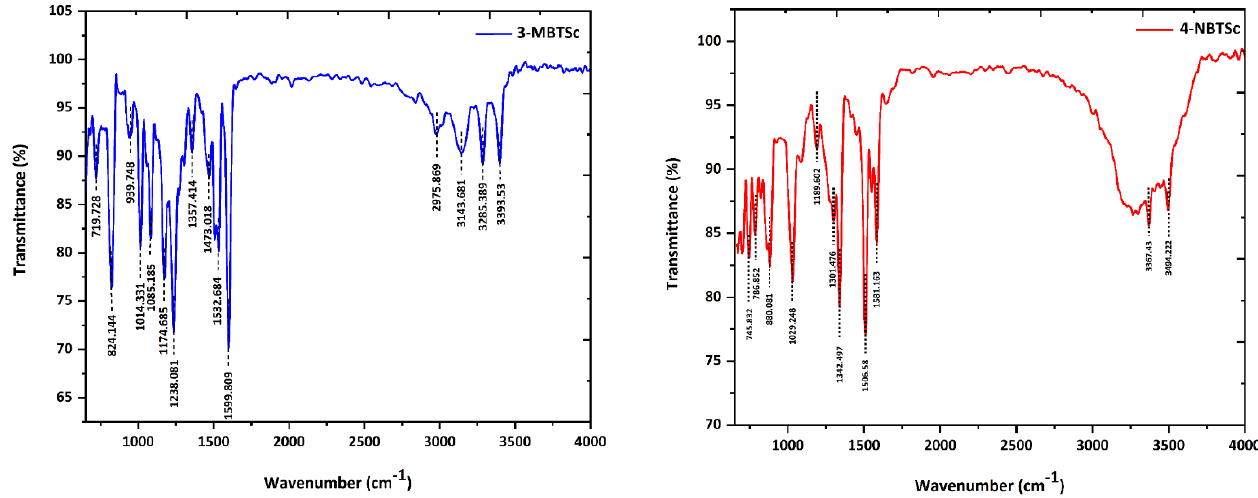
Figure 3. FTIR spectra of 3-MBTSc and 4-NBTSc compounds in the wavenumber range of 600–4000 cm − 1